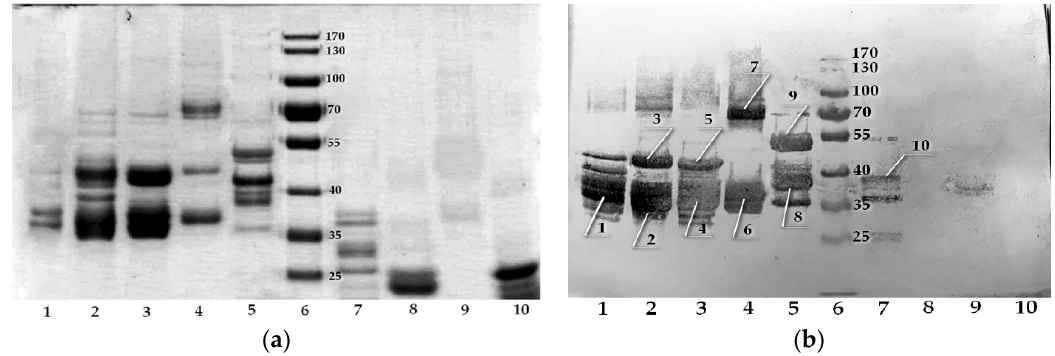
Figure 3. Electrophoresis of various prolamins ( a ) 1— Triticum urartu , 2— Triticum turgidum , 3— Triticum aestivum , 4— Secale cereale , 5— Hordeum vulgare , 6—molecular weight marker, kDa, 7— Avena sativa , 8— Zea mays , 9— Dasypyrum villosum , 10— Setaria italica ; ( b ) western blotting of X6. Lines indicate the bands analyzed by MALDI-TOF, the results of which are shown in Table 4. Table 4. X6 antibody specificity based on MALDI-TOF data.